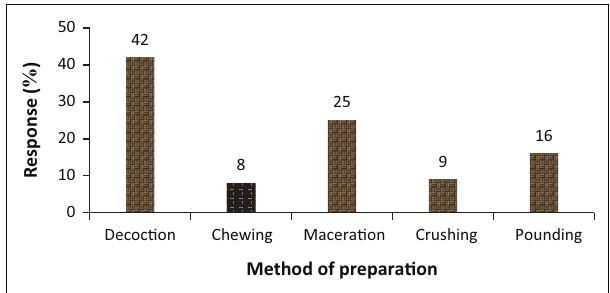
FIGURE 4: Methods of preparation of the herbal remedies.